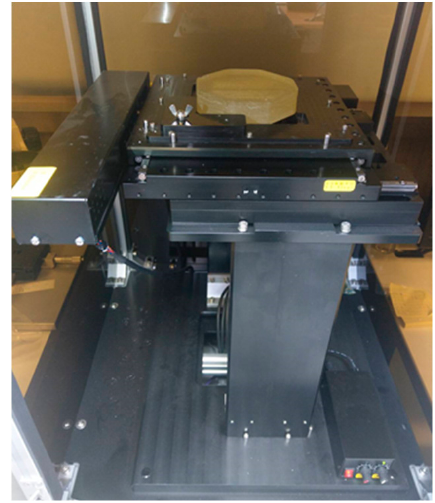
Figure 4. Optical microscopy